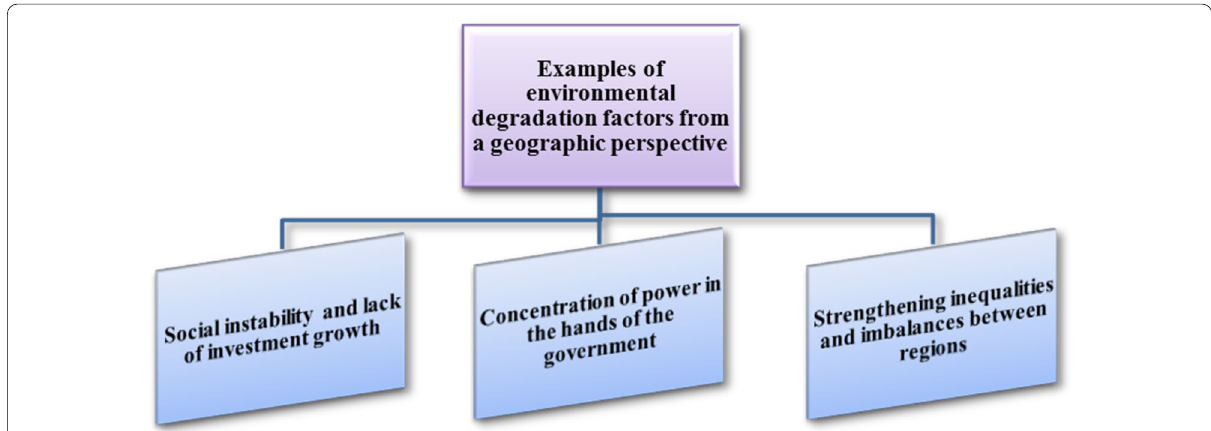
Fig. 2 examples of destructive environmental factors from a geopolitical point of